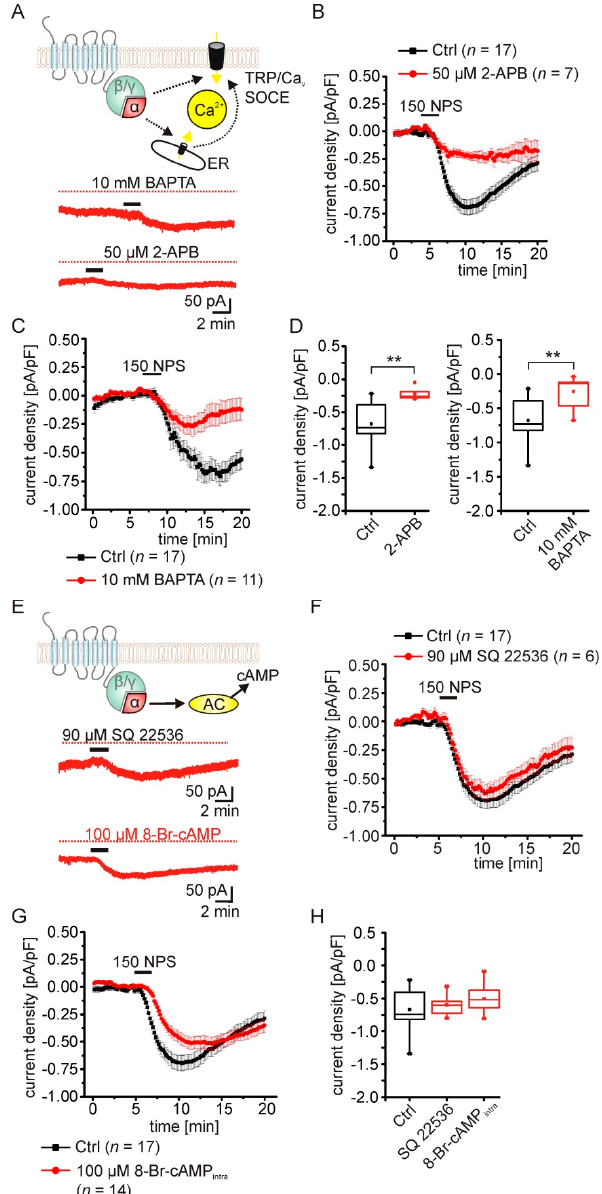
Figure 4. The NPSR1-mediated current depends on a rise of intracellular calcium concentration. ( A ) Activation of the NPSR1 might trigger intracellular signaling cascades leading to a rise of the cytosolic calcium concentration. Putative calcium sources might be the endoplasmic reticulum (ER) or the extracellular space, with TRP channels or store-operated calcium entry (SOCE) as possible routes. ( B ) The transient NPS-induced current is reduced in the presence of 50 µM 2-APB in the